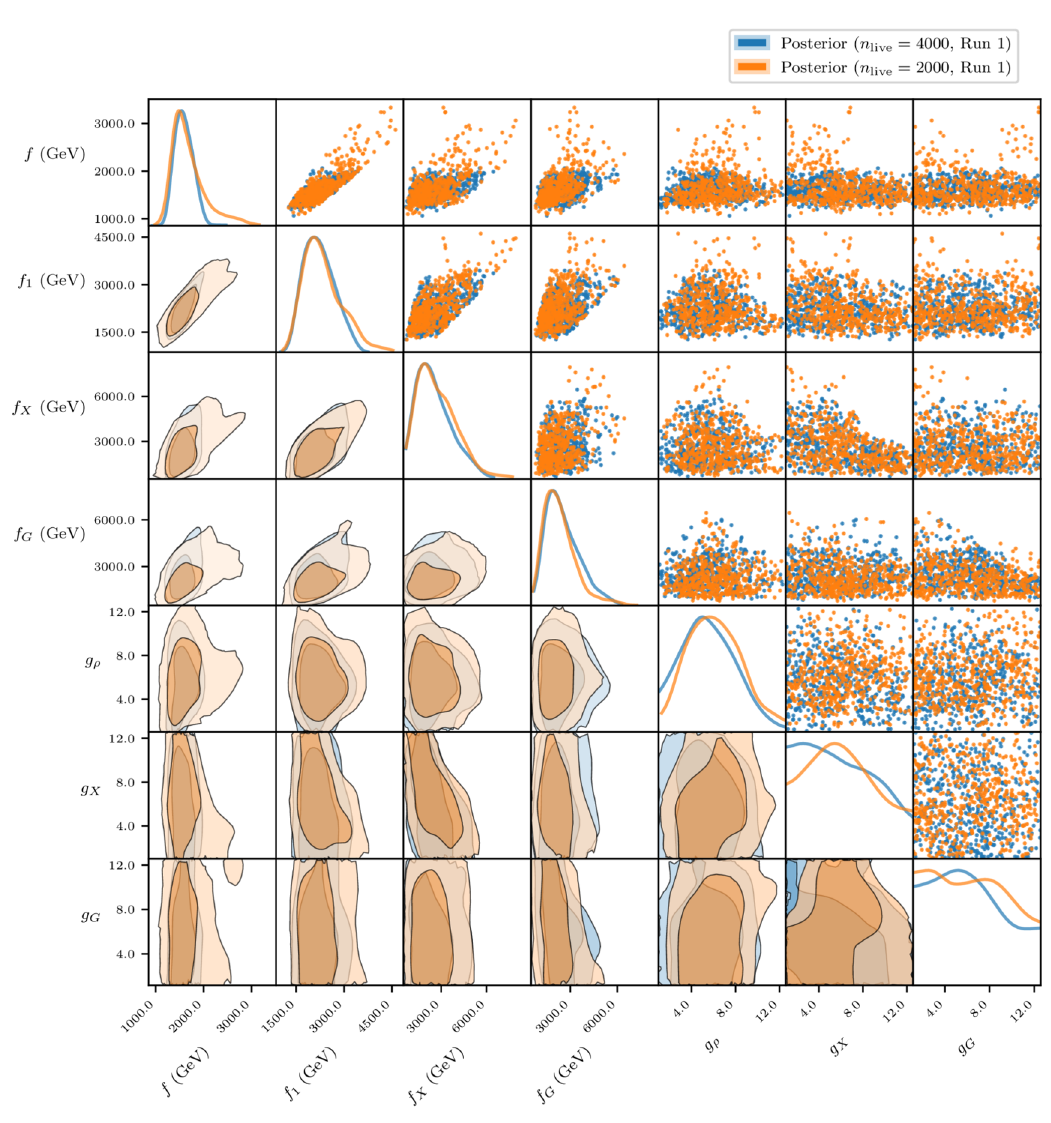
Figure 23. 1D and 2D marginalised posteriors for the gauge sector parameters in the M4DCHM 14 − 1 − 10 found in two different runs with 2000 and 4000 live points